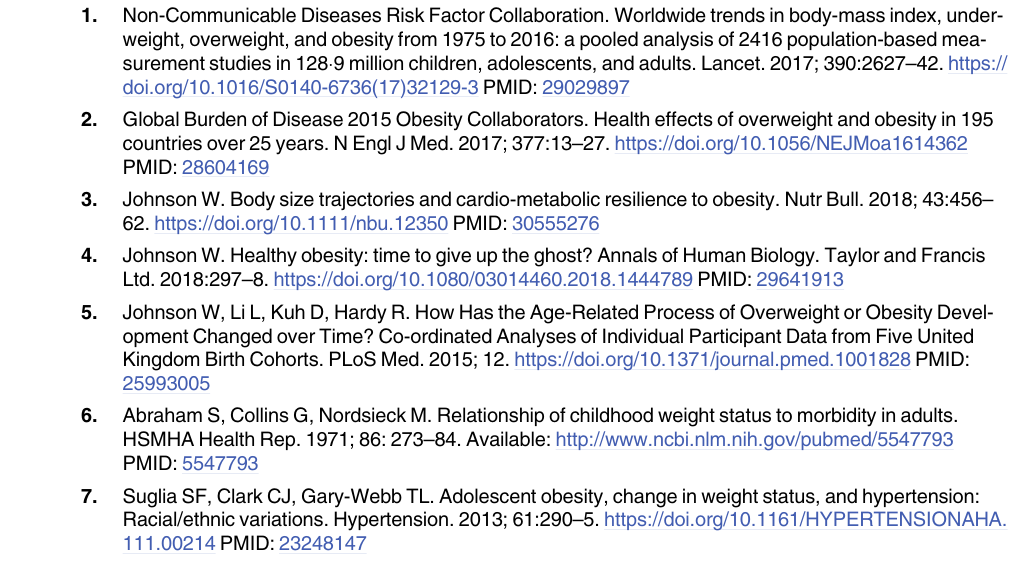
S13 Table. Association between ever obese and categories of obesity duration (versus never obese) and cardiometabolic disease risk factors (imputed, adjusted for sex, cohort, age at follow-up, ethnicity, birth weight, childhood social class, and obesity severity): limited to those who once obese were always obese. S14 Table. Association between ever obese and categories of obesity duration (versus never obese) and dichotomous cardiometabolic outcomes (imputed, adjusted for sex, cohort, age at follow-up, ethnicity, birth weight, childhood social class, and obesity severity): limited to those who once obese were always obese. S1 Fig. Sample flow